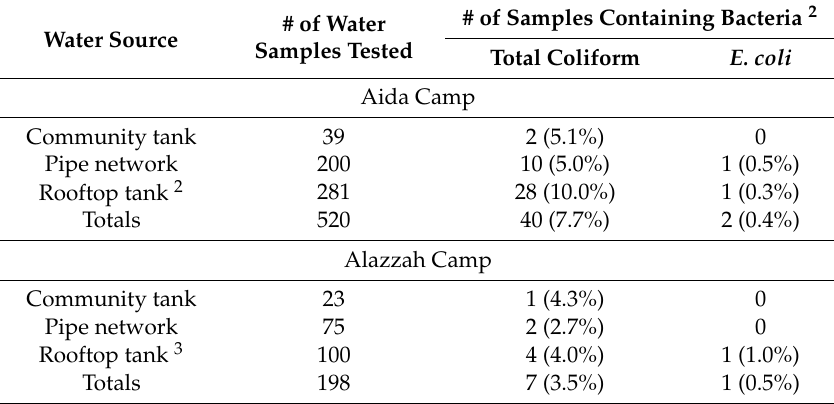
Table 1. Summary of Bacterial Testing Results 1